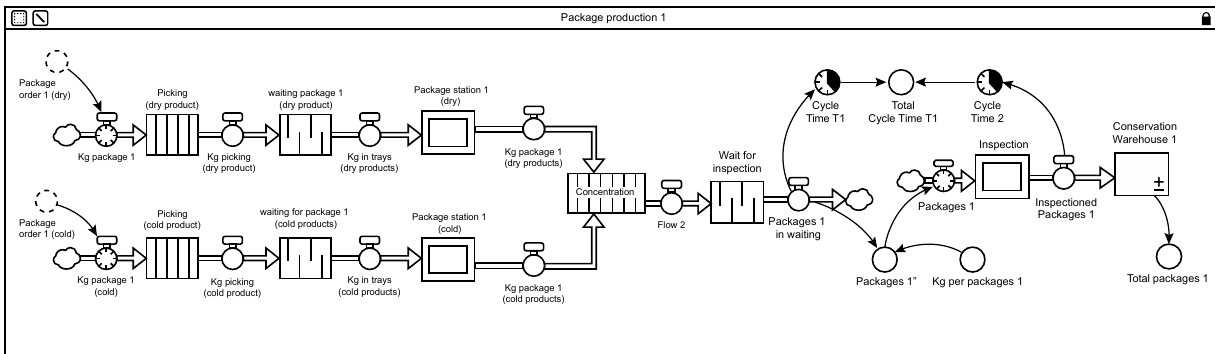
Figure 9. Forrester diagram of the packaging process for the optimistic model.